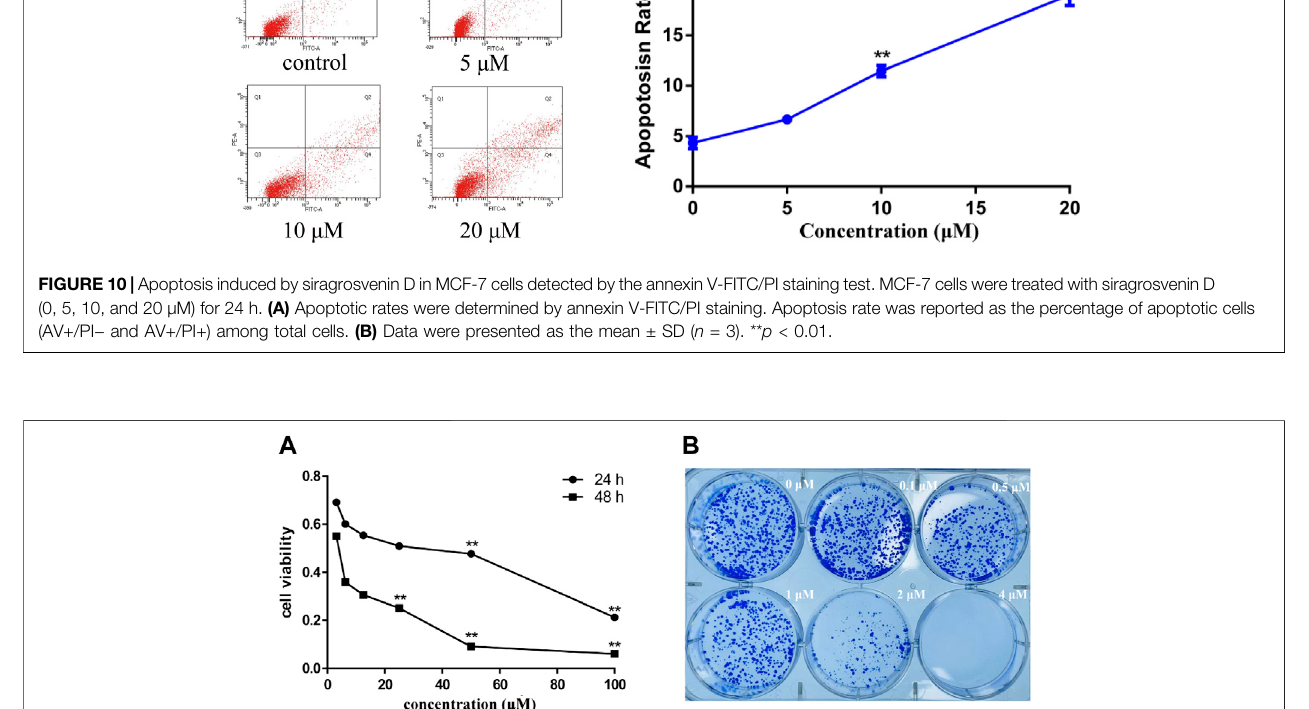
FIGURE 11 | Cytotoxicity of siragrosvenin D. (A) MTT assay was performed to assess cell viability in MCF-7 cells treated with different concentrations of siragrosvenin D for 24 and 48 h. (B) Effect of siragrosvenin D on colony formation. All data are presented as mean ± SD. ** p < 0.01.